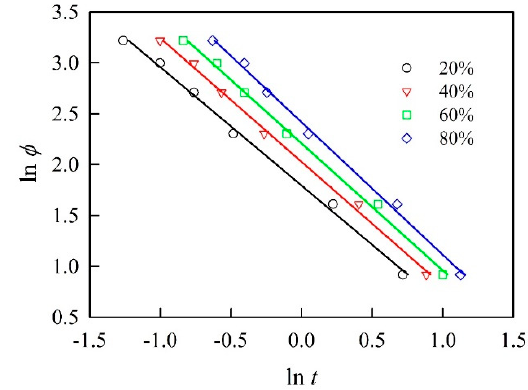
Figure 3. Avrami–Ozawa plots of ln ϕ versus ln t for polypropylene with unmodified bamboo fibers. Table 4. Parameters calculated at various relative crystallinities ( X ) based on the Avrami–Ozawa model.